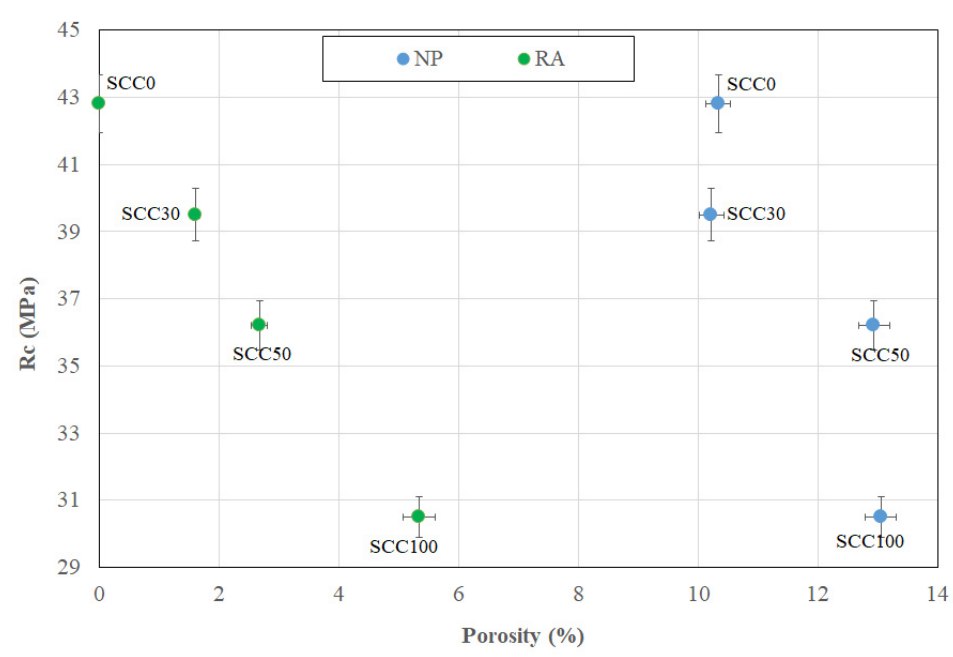
Figure 9. Relationship between porosity of RAC component and compressive strength.